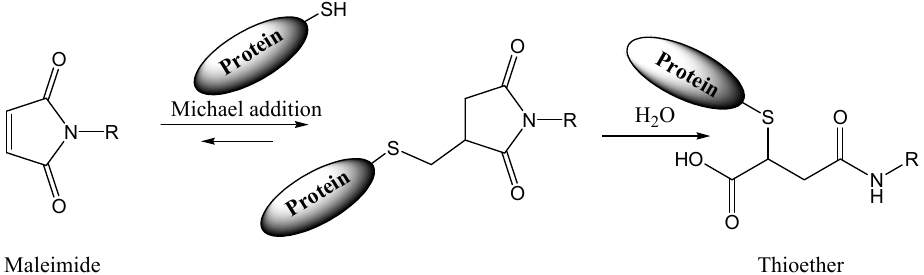
Figure 13. Mechanism of thiol ‐ specific protein crosslinking using maleimide as crosslinker.